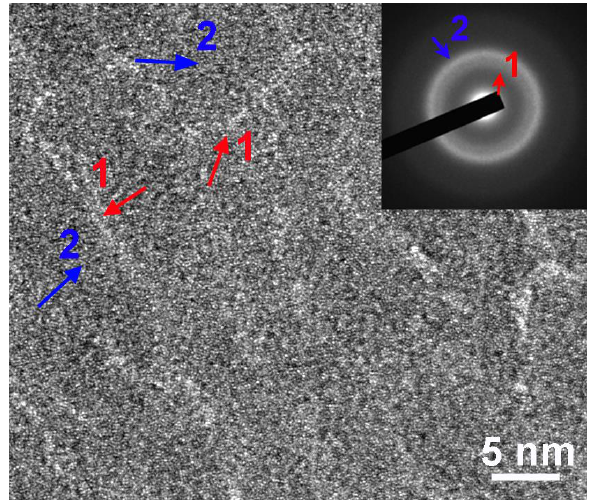
Figure 4. HRTEM image of the CrFeMoNbZrO x thin film. The inset is the SAED pattern of the thin film.